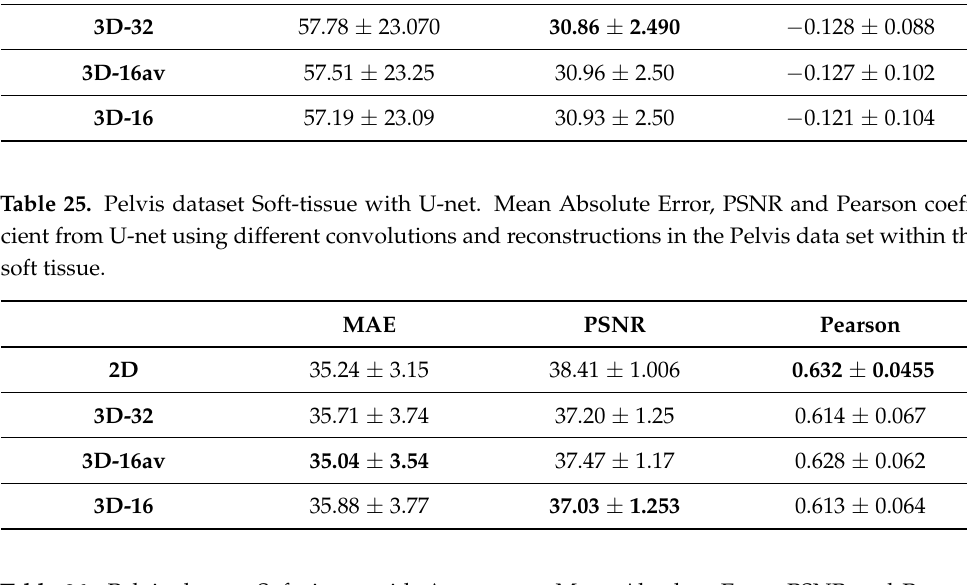
Table 26. Pelvis dataset Soft-tissue with Atrous-net. Mean Absolute Error, PSNR and Pearson coefficient from Atrous-net using different convolutions and reconstructions in the Pelvis data set within the soft tissue.